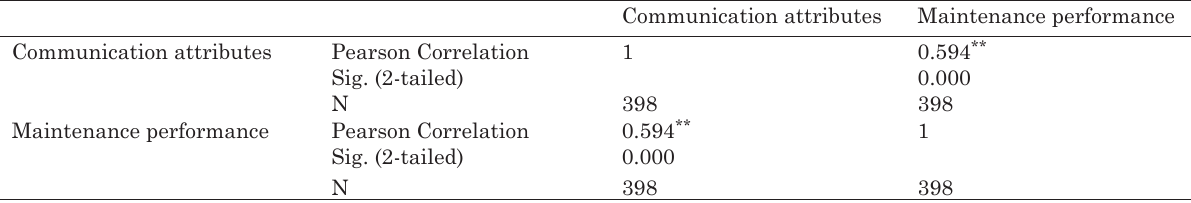
Table 4. Correlation between communication and performance of maintenance